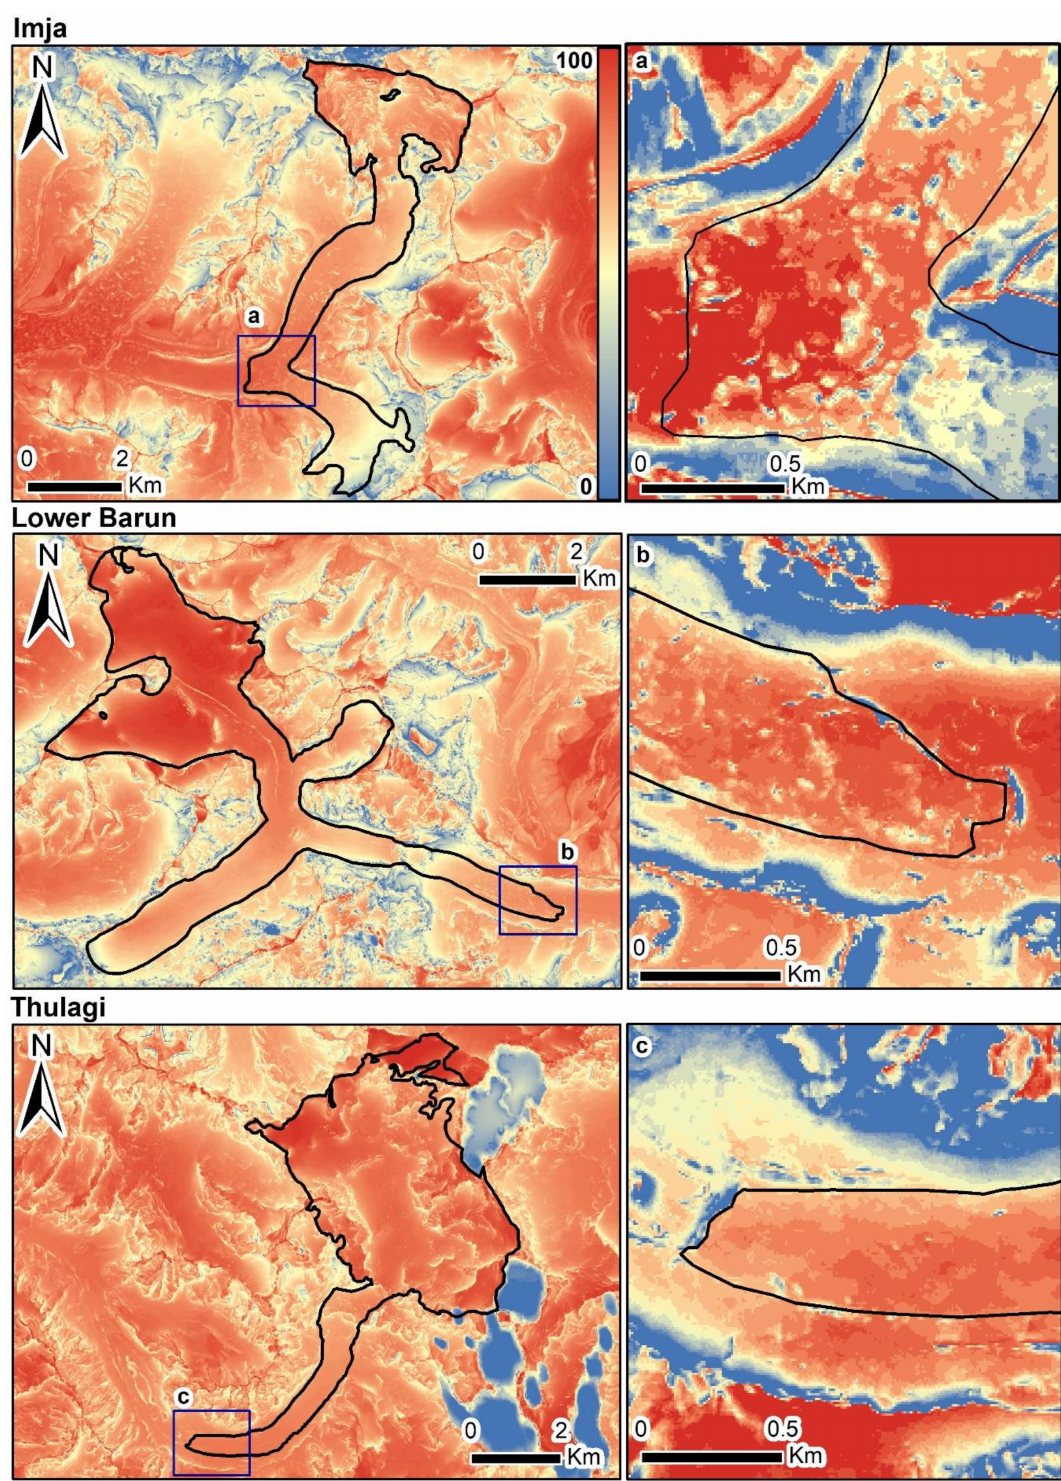
Figure 7. Normalized distribution showing a sky-view factor percentage. Blue tones represent relatively high topographic shielding of diffuse skylight irradiance and red tones indicate a full hemispherical view. A zoomed view of the terminus region (blue rectangle) stretched with a standard deviation of 1 to reflect the range of distribution and smooth texture at Thulagi due to the relative absence of supraglacial ponds and ice cliffs compared to the Imja and Lower Barun